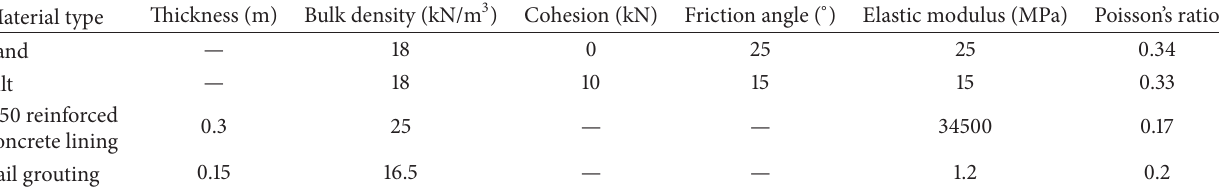
Table 2: Physical and mechanical parameters of the